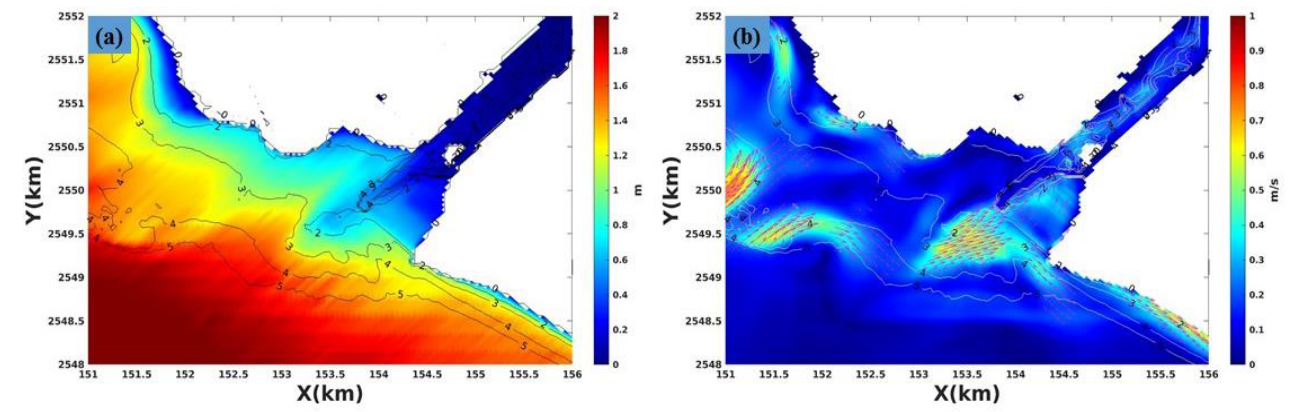
Figure 10. The simulated ( a ) significant wave heights (scale on the right, contour: depth) and ( b ) flow field (color: flow speed, vector: flow direction, scale on the right, contour: depth) under stormy wave conditions.